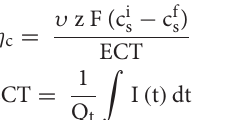
considered as optimum value for water quality (Council Directive 75/440/EEC,